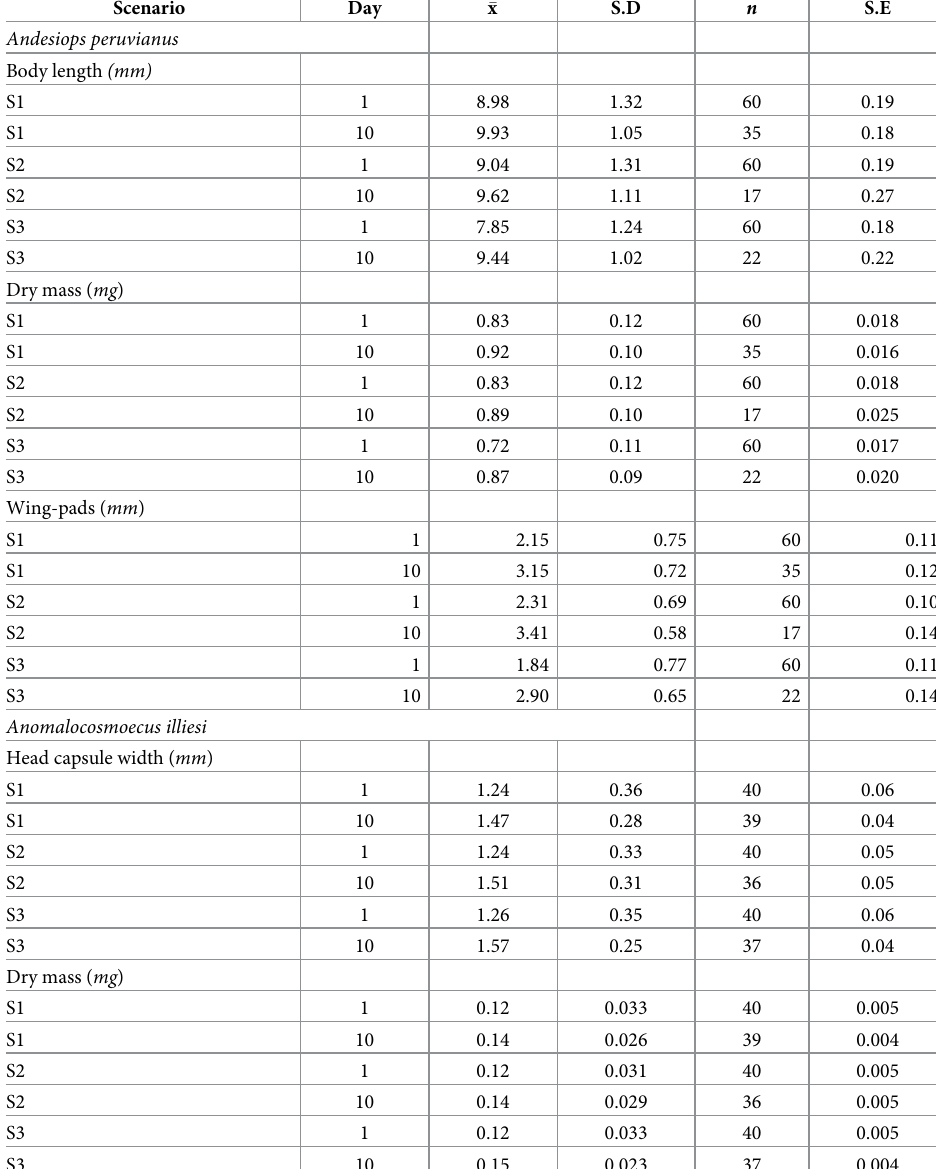
Table 4. Mean ( � x ), standard deviation (SD), and standard error (SE) of body length, wing-pad length and dry mass from Andesiops peruvianus and Anomalocosmoecus illiesi head capsule width and dry mass. S1 (control), S2 (+2.5˚C) and S3 (+5˚C). n , number of individuals